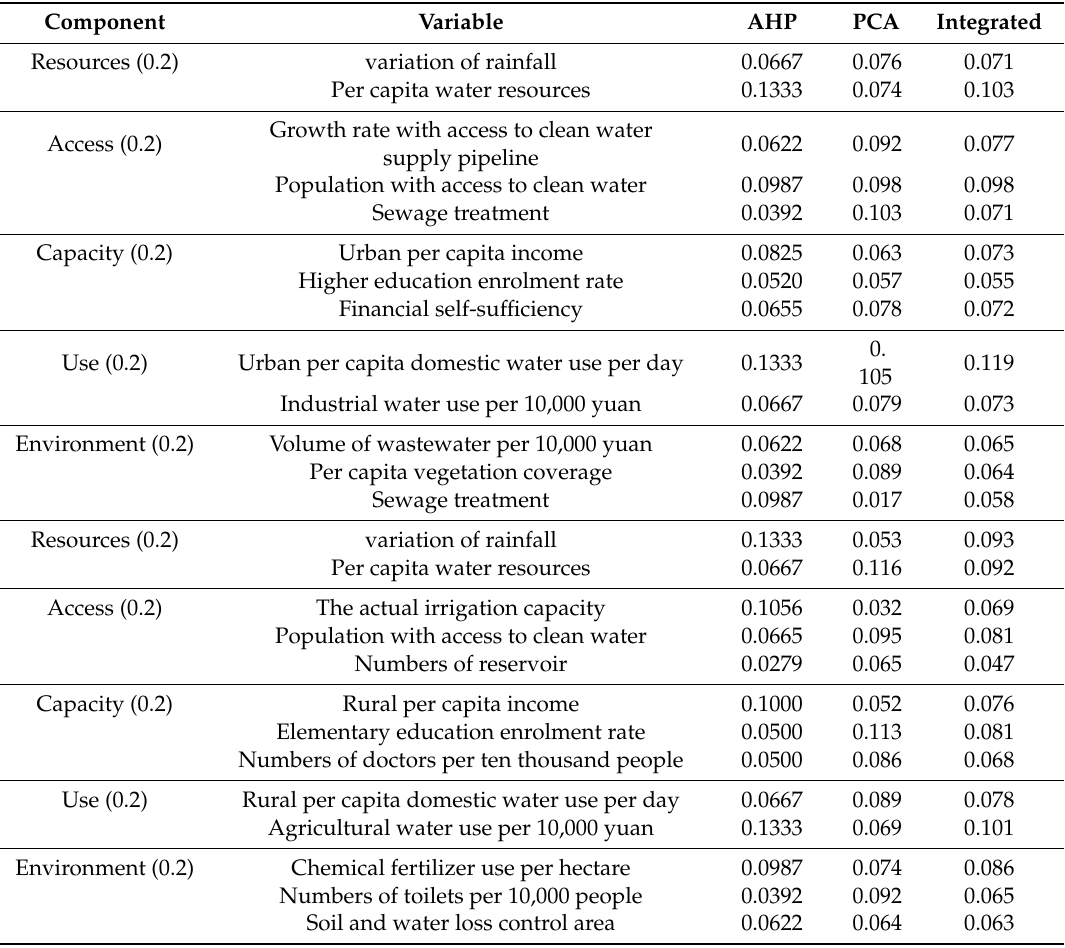
Table 4. Weights of the WPI components,